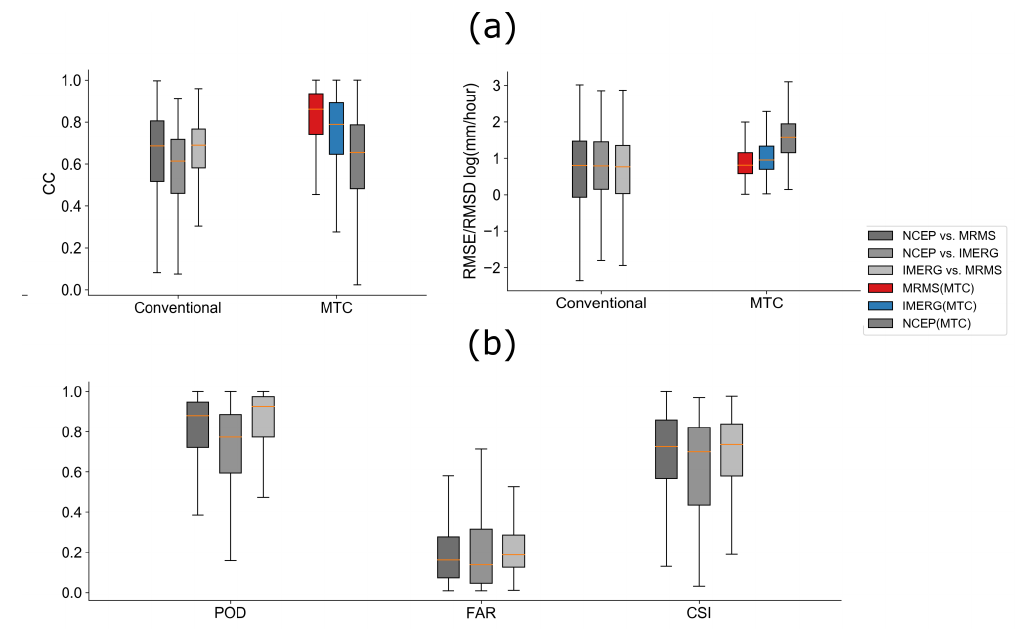
Figure 4. Boxplot for conventional metrics and MTC results in Hurricane Harvey. ( a ) Continuous indices and MTC results; ( b ) categorical